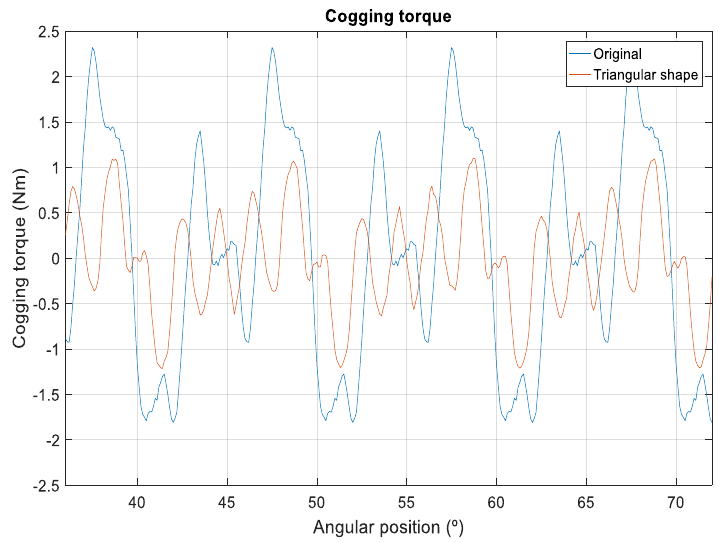
Figure 8. Comparison of cogging torque reduction with the triangular pre-slot method.